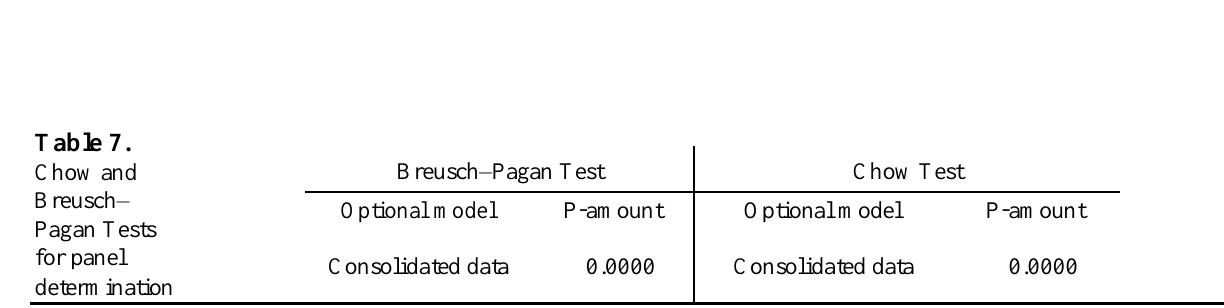
Table 6. The relationship between the quality of financial reporting, the market value added, and control variables.